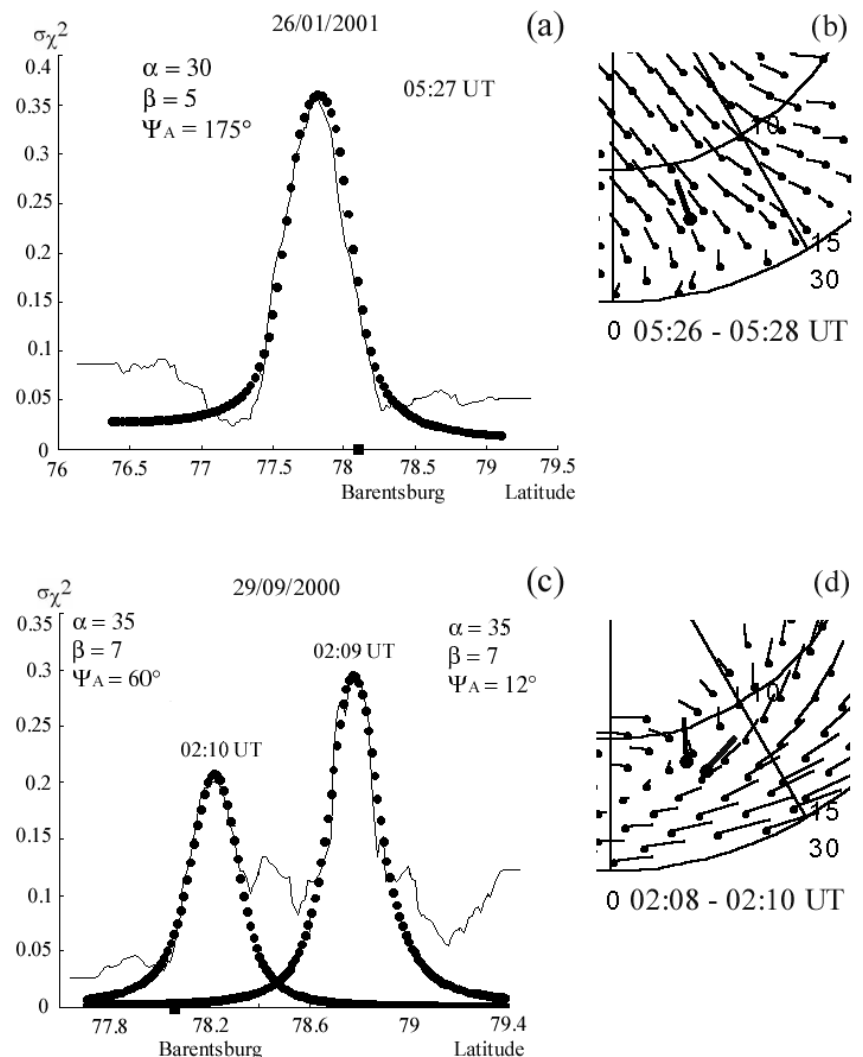
Fig. 1. (a) and (c) Two examples of observed latitudinal changes in the variance of the logarithm of the relative scintillation amplitude σ 2 χ (thin line) and corresponding fitted theoretical curves (dots), according to the method by Tereshchenko et al. (1999, 2000a, b, 2002, 2004, 2005). Inferred parameters of ionospheric irregularities α , β and 9 A are given for every scintillation amplitude peak. Panel (a) (panel c) corresponds to a case of one (two) maximum in the distribution of σ 2 χ . Panels (b) and (d) show SuperDARN-observed convection velocities (lines originated from dots). The geographic coordinates are used. The thick vectors on the panels (b) and (d) indicate the orientation of the cross-field anisotropy of F-region irregularities, as inferred from scintillation data. b, 2002, 2004, 2005) is capable of detecting those